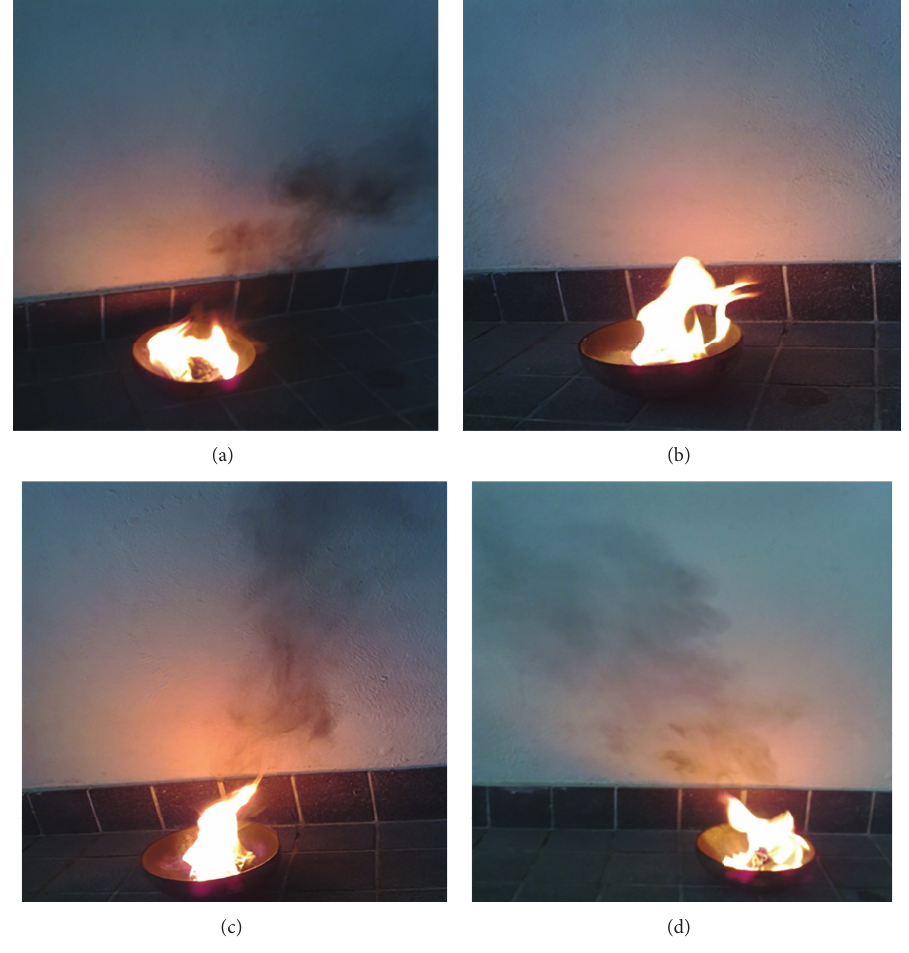
Figure 4: Burning of (a) B0, (b) B100, (c) B20, and (d) B40. Table 2: Diesel engine testing results for different blends of castor